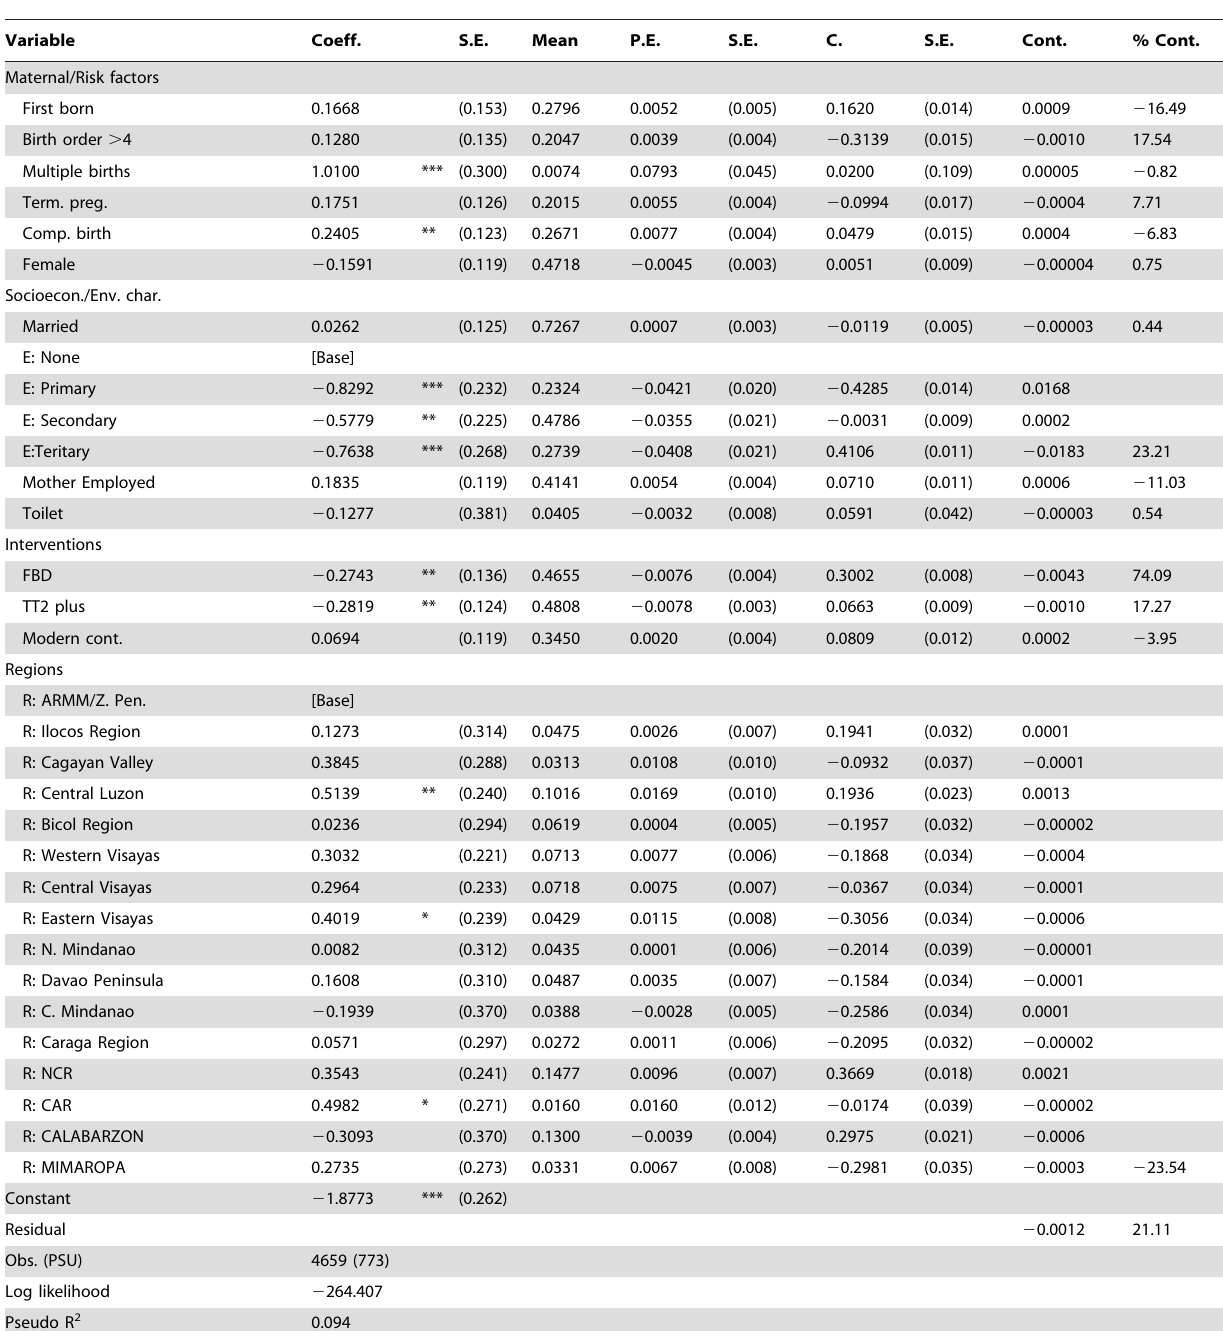
Table 3. Decomposition analysis of inequality in neonatal mortality, Philippines 2008.